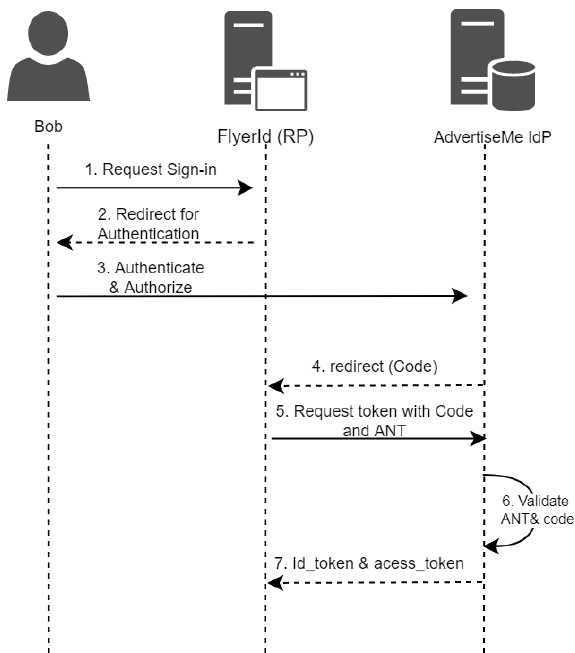
Figure 6. Authentication